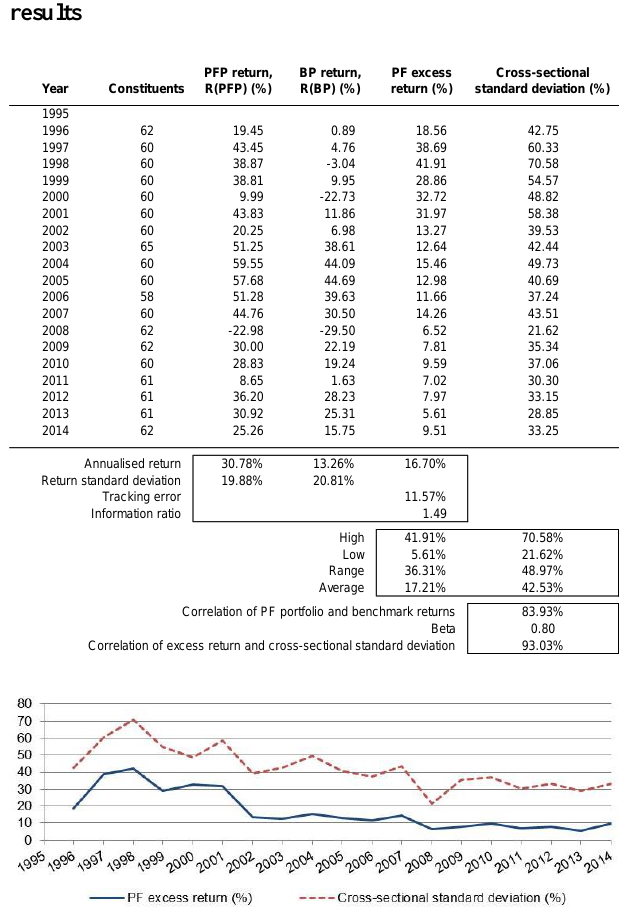
Table 5: Small cap segment benchmark and PF portfolio results